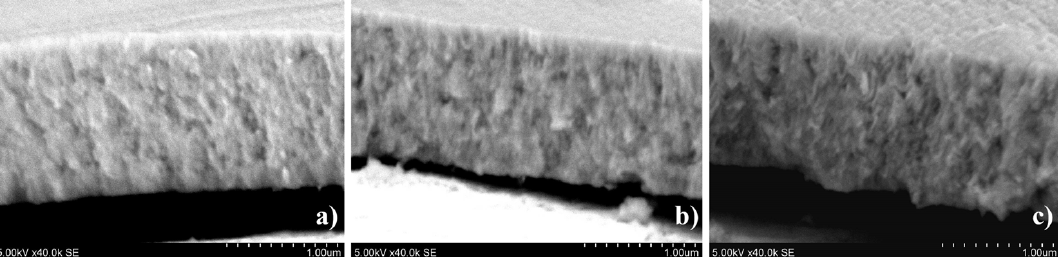
Figure 5. Cross-section images of ScAlSZ thin films deposited using 0.4 nm/s deposition rate and different substrate temperatures: ( a ) 50 °C, ( b ) 300 °C, and ( c ) 600 °C.